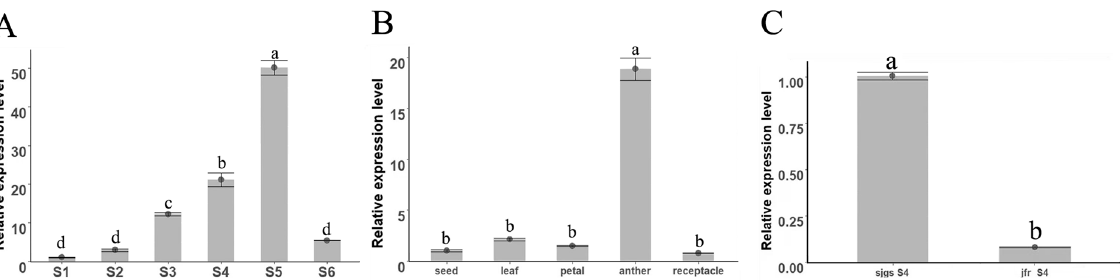
Figure 4. Expression analysis of NnPTC1 in ‘Jinfurong 1’. ( A ) Expression of NnPTC1 in lotus anthers at different pollen development stages. ( B ) Expression of NnPTC1 in different parts of lotus. ( C ) Expression of NnPTC1 in ‘Sijinggangshan’ and ‘Jinfurong 1’ during pollen development at the mononuclear stage. S1, Pollen mother cell stage; S2, meiotic phase; S3, tetrad period; S4, Mononuclear period, S5, Binucleate period; S6, pollen grain maturity; sjgs, ‘Sijinggangshan’; jfr, ‘Jinfurong 1’. Values are the means ± SE of three independent experiments with at least three replicates for each. According to Tukey’s multiple test, bars marked with different letters are significantly different at p < 0.05.